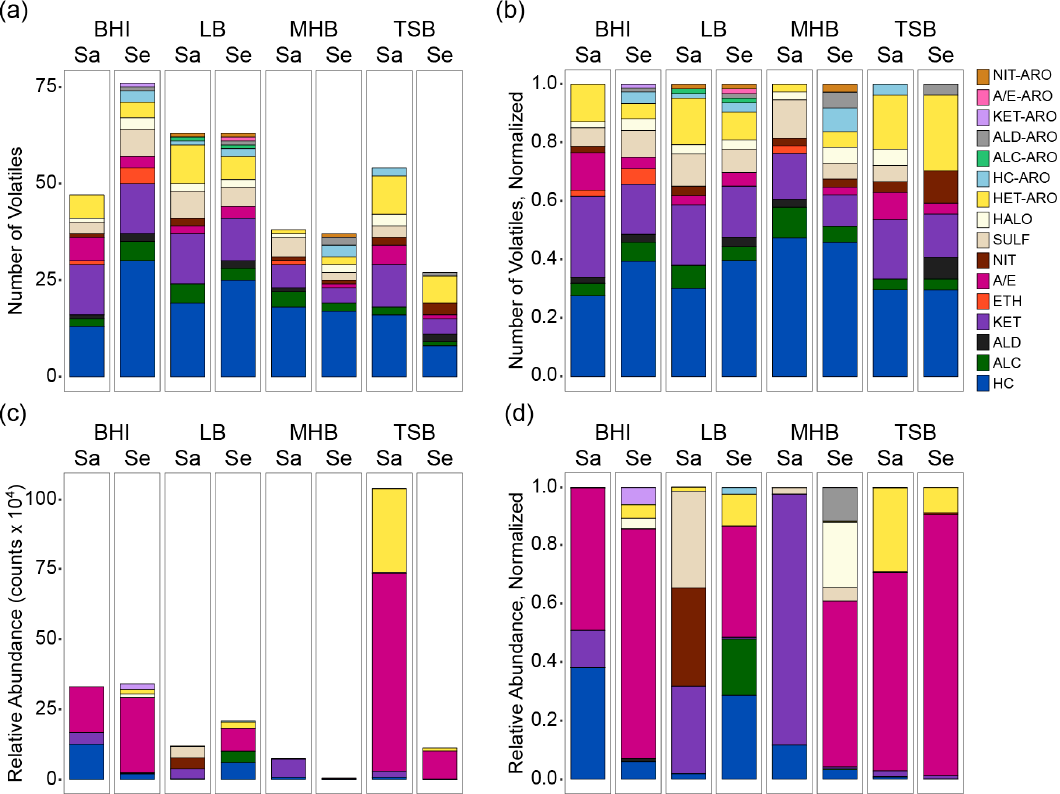
Figure 3. Chemical composition of the staph volatilome as a function of species and growth medium. The data are presented as the total number of volatiles detected in each chemical class, unnormalized ( a ) and normalized ( b ), and the total relative abundances of volatiles in each chemical class, unnormalized ( c ) and normalized ( d ). Level 4 (unknown) compounds were excluded. The numerical data are provided in Tables S2–S5. HC, hydrocarbons; ALC, alcohols; ALD, aldehydes; KET, ketones; ETH, ethers; A/E, acids and esters; NIT, nitrogen-containing; SULF, sulfur-containing; HALO, halogen-containing; HET-ARO, heteroaromatics; HC-ARO, aromatic hydrocarbons; ALC-ARO, aromatic alcohols; ALD-ARO, aromatic aldehydes; KET-ARO, aromatic ketones; A/E-ARO, aromatic acids and esters; NIT-ARO, aromatic nitrogen-containing.